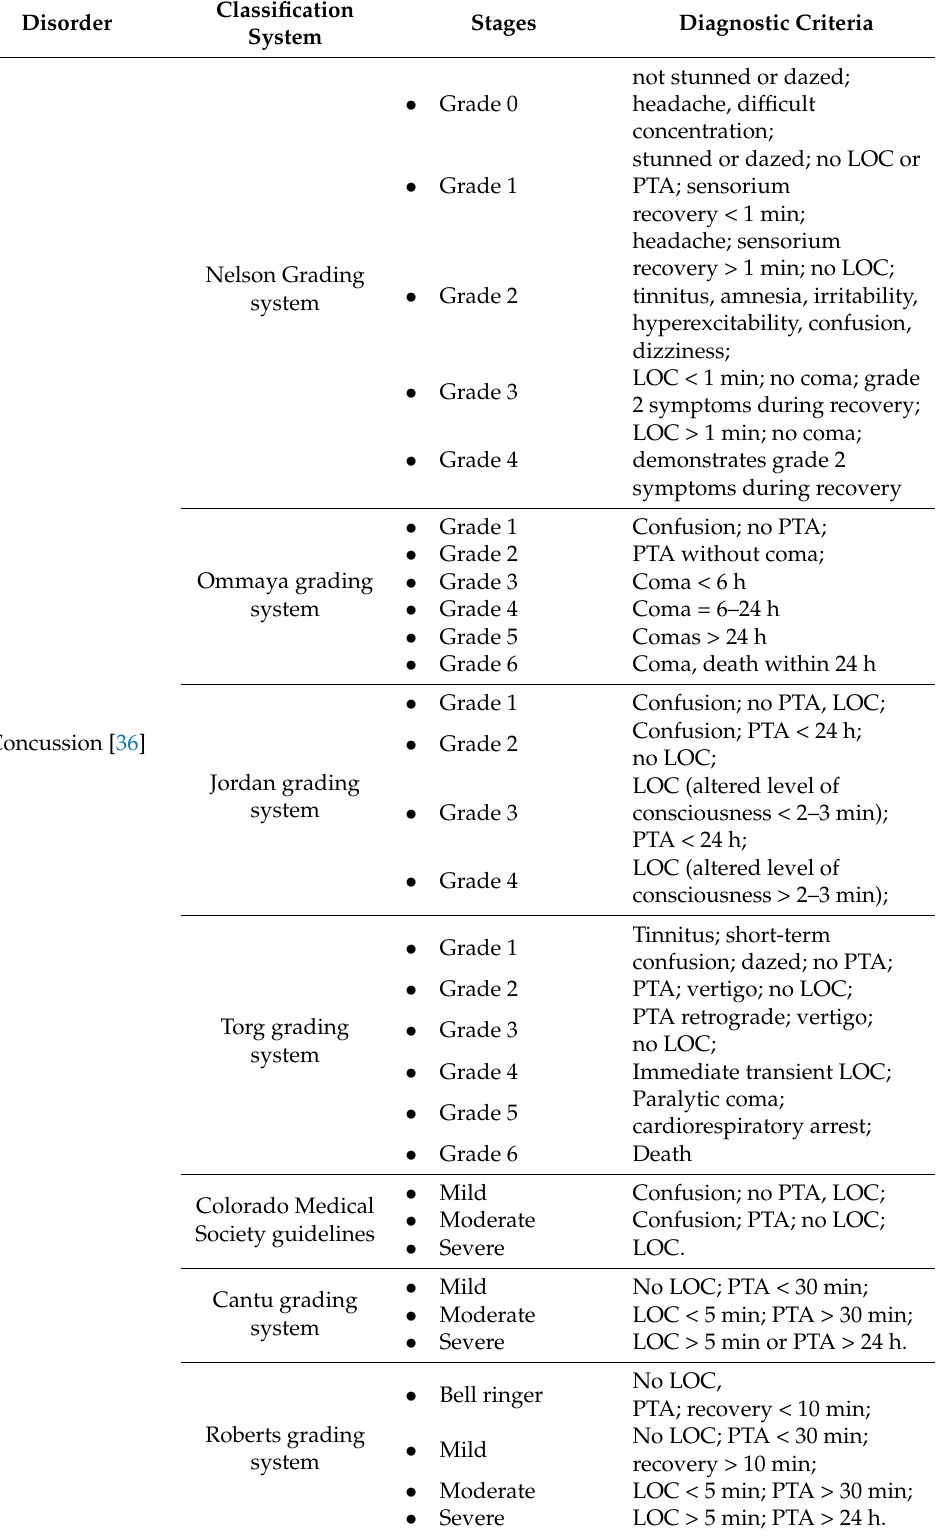
Table 1. Classification systems of head injury syndromes and diagnostic